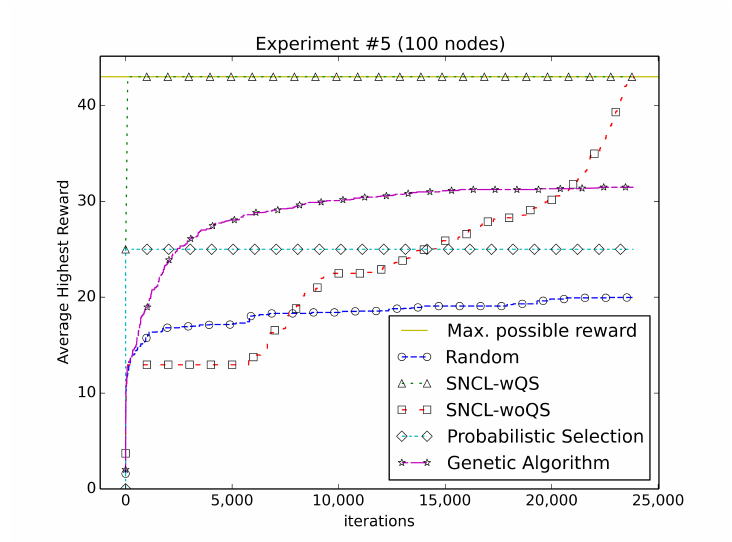
Figure 7. Using reward Equation